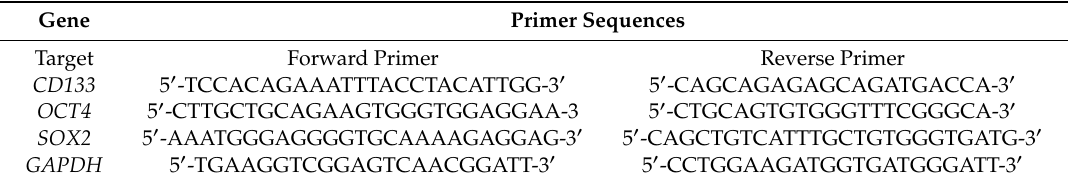
Table 3. Primers for CD133 , OCT4 , SOX2 and GAPDH